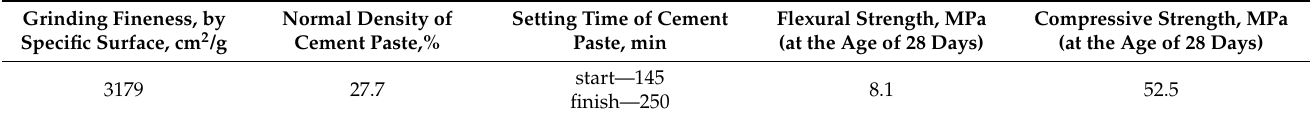
Table 1. Characteristics of Portland cement PC 500 D0.